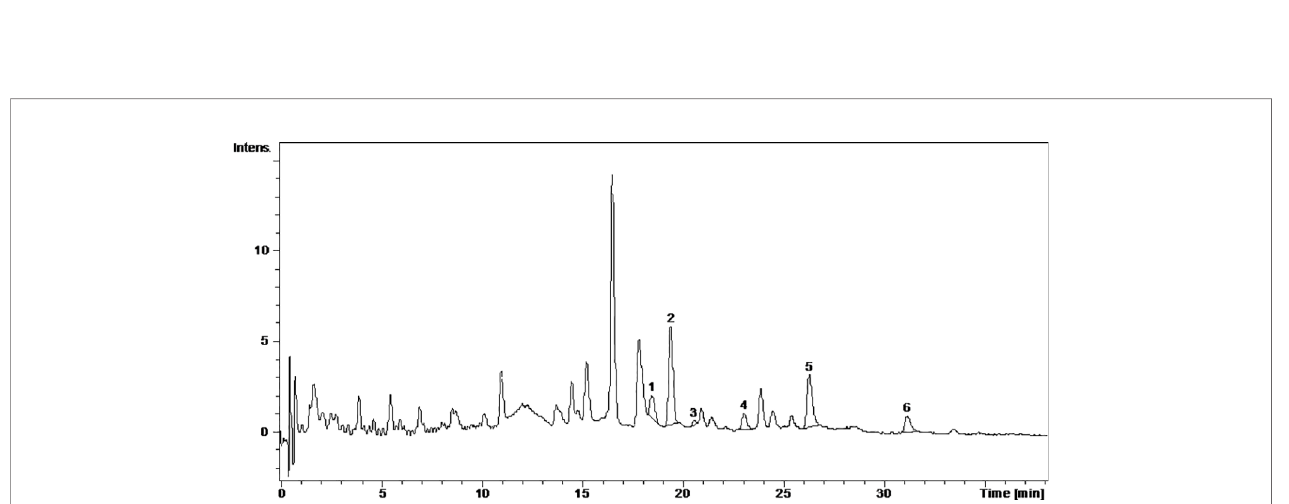
FIGURE 3 | The UV chromatogram offresh Feteasca ̆ neagra ̆ 2015 grape pomace extract. 1, Hyperoside; 2, Isoquercitrin; 3, Miricetol; 4, Quercitrin; 5, Quercetin; 6,